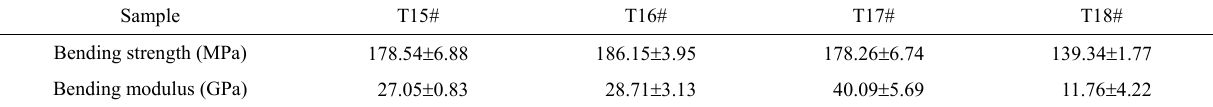
Table 6 Bending strengths of C pf /SiC composites prepared at different siliconization temperatures